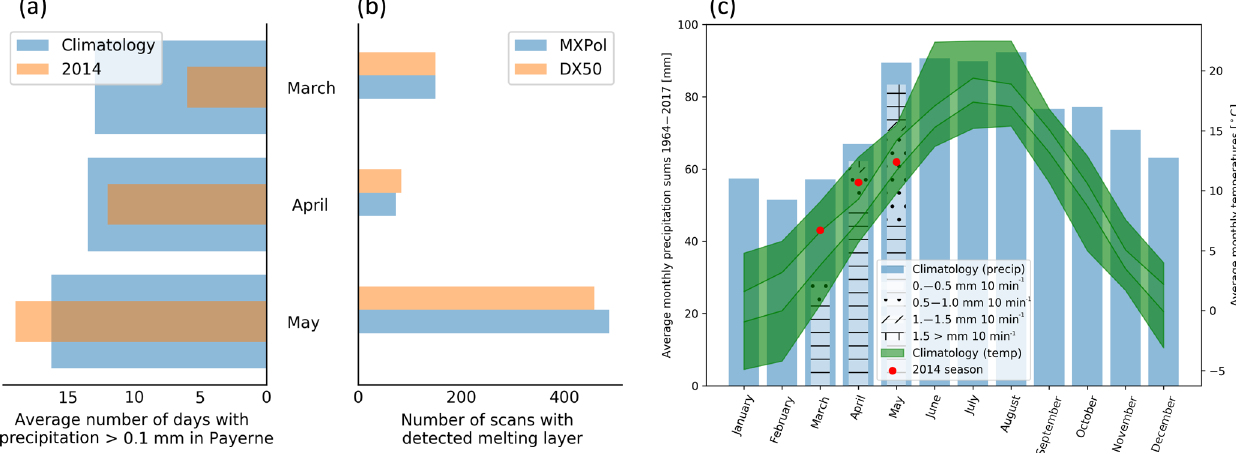
of the campaign and performed one RHI scan in the direc- tion of the Plaine Morte (47 ◦ ), one hemispheric RHI in the axis of the main valley (54 ◦ ), one RHI in fast Fourier trans- form (FFT) mode in the direction of Pierre Avoi mountain (90 ◦ ), one RHI which made a cross section of the main val- ley (147 ◦ ) and a vertical PPI scan in FFT mode. Both FFT mode scans were performed at 30 m resolution, and the DPP mode scans were performed with 75 m